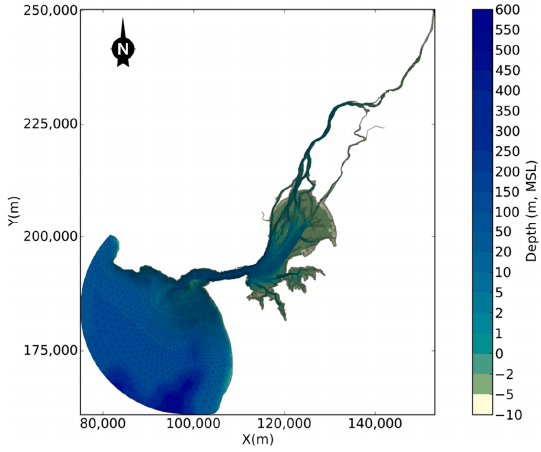
Figure 2. Horizontal grid and bathymetry (MSL, mean sea level) of the Tagus estuary.